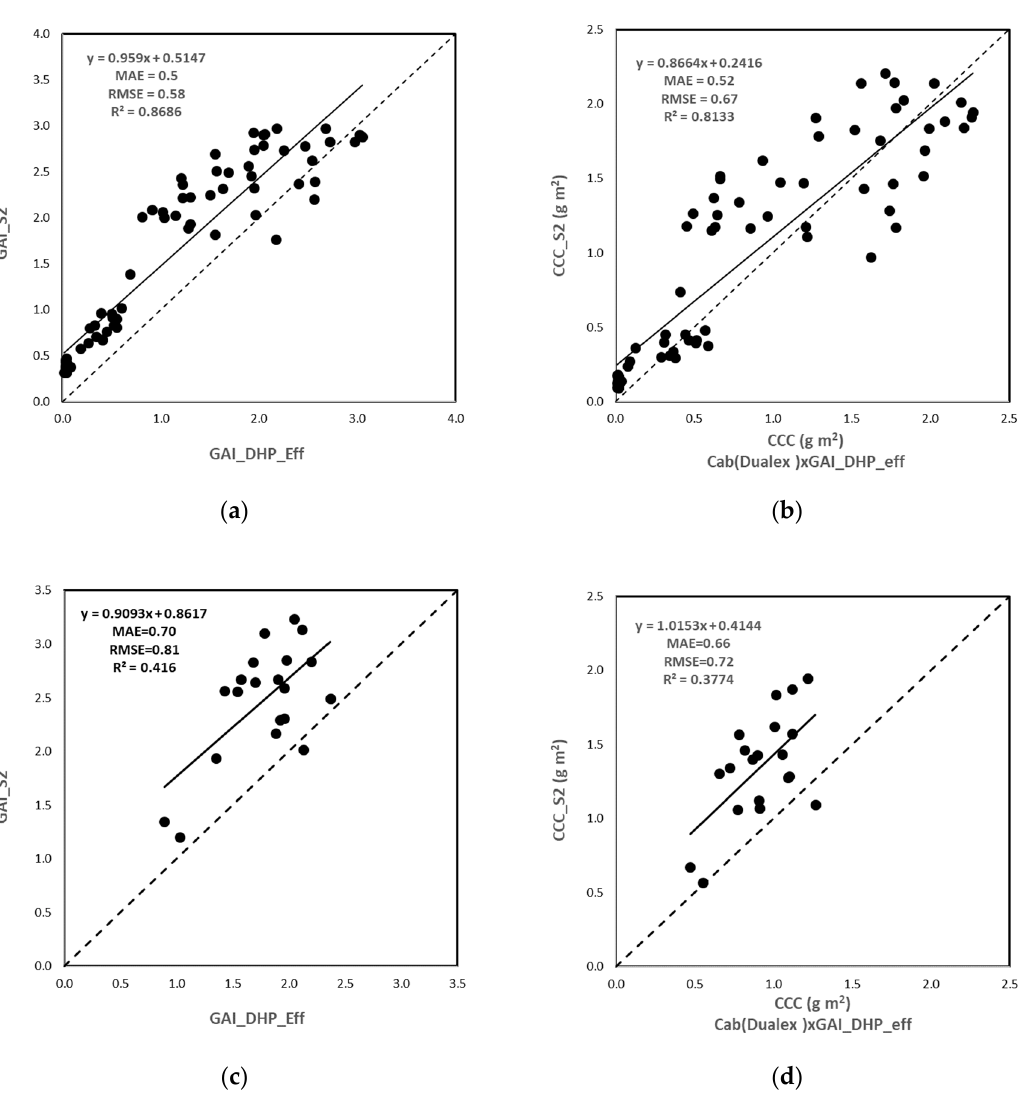
Figure 6. Scatterplot and statistics computed for Green Area Index (GAI) and Canopy Chlorophyll Content (CCC) retrieved from Sentinel-2 images. Relationships in maize crop from the 2nd leaf stage to silking stage (4 S2 images) between: ( a ) GAI estimated from S2 (GAI_S2) and measured GAI (GAI_DHP_effective); ( b ) CCC from S2 (CCC_S2) and measured CCC (Cab Dualex × GAI_DHP_eff). Relationships in wheat crop for tillering between: ( c ) GAI from S2 (GAI_S2) and measured GAI (GAI_DHP_effective); ( d ) CCC estimated from S2 (CCC_S2) and measured CCC (Cab Dualex × GAI_DHP_eff).